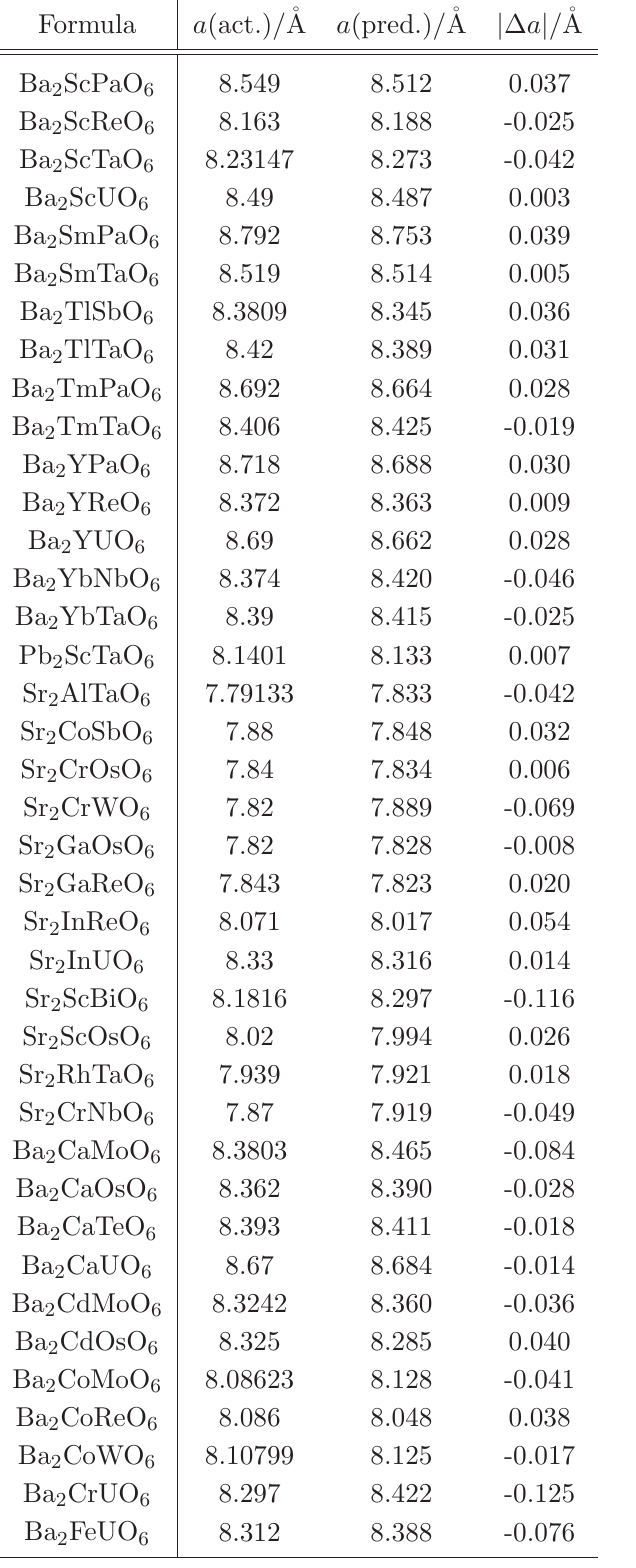
Table 3 (continue) Actual, predicted values for the unit cell length, as well as, absolute errors for the compounds of the calibration set obtained by